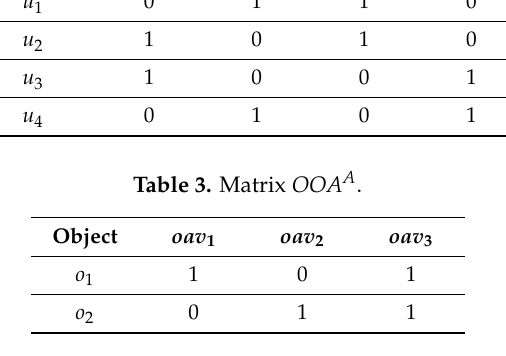
Table 4. Matrix UOP A